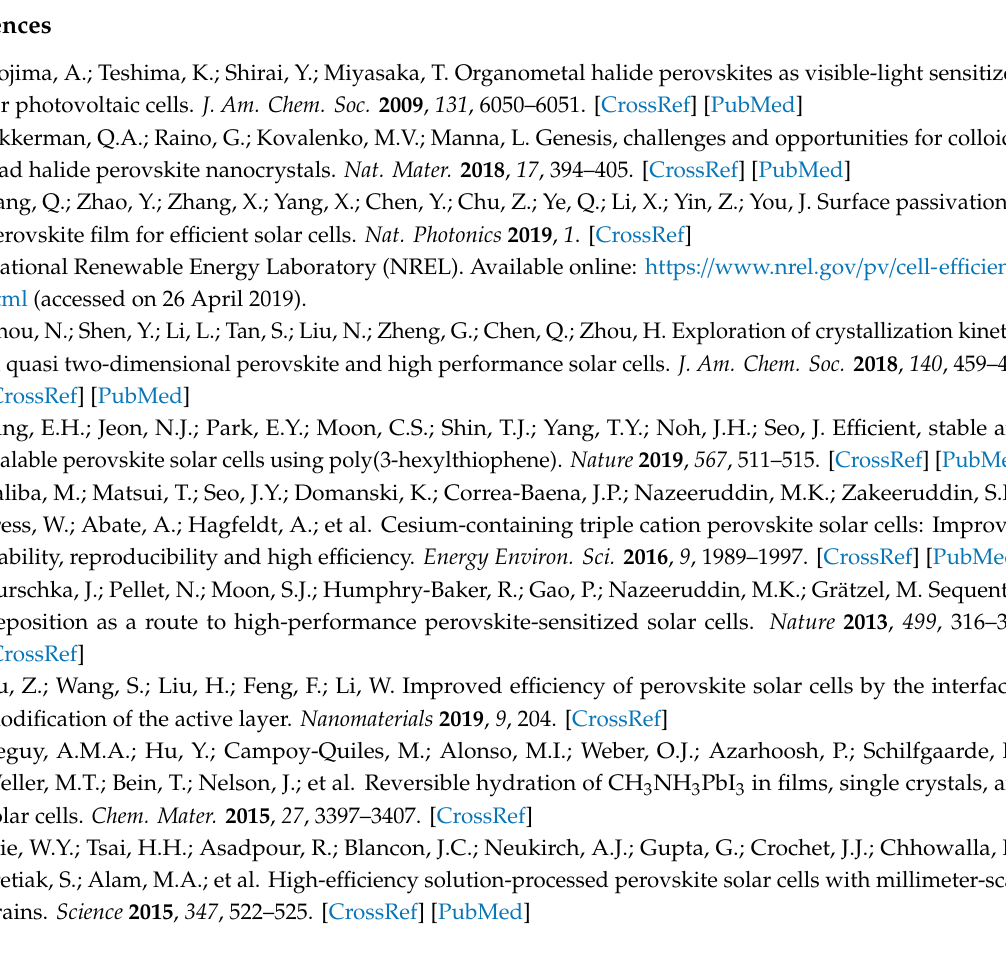
Figure S1: TEM images and the corresponding fast Fourier transform (FFT) patterns of BA 2 PbBr 4 nanosheets at di ff erent magnifications, Figure S2: TEM images and the corresponding FFT of a BA 2 PbBr 4 nanosheet under electron beam during